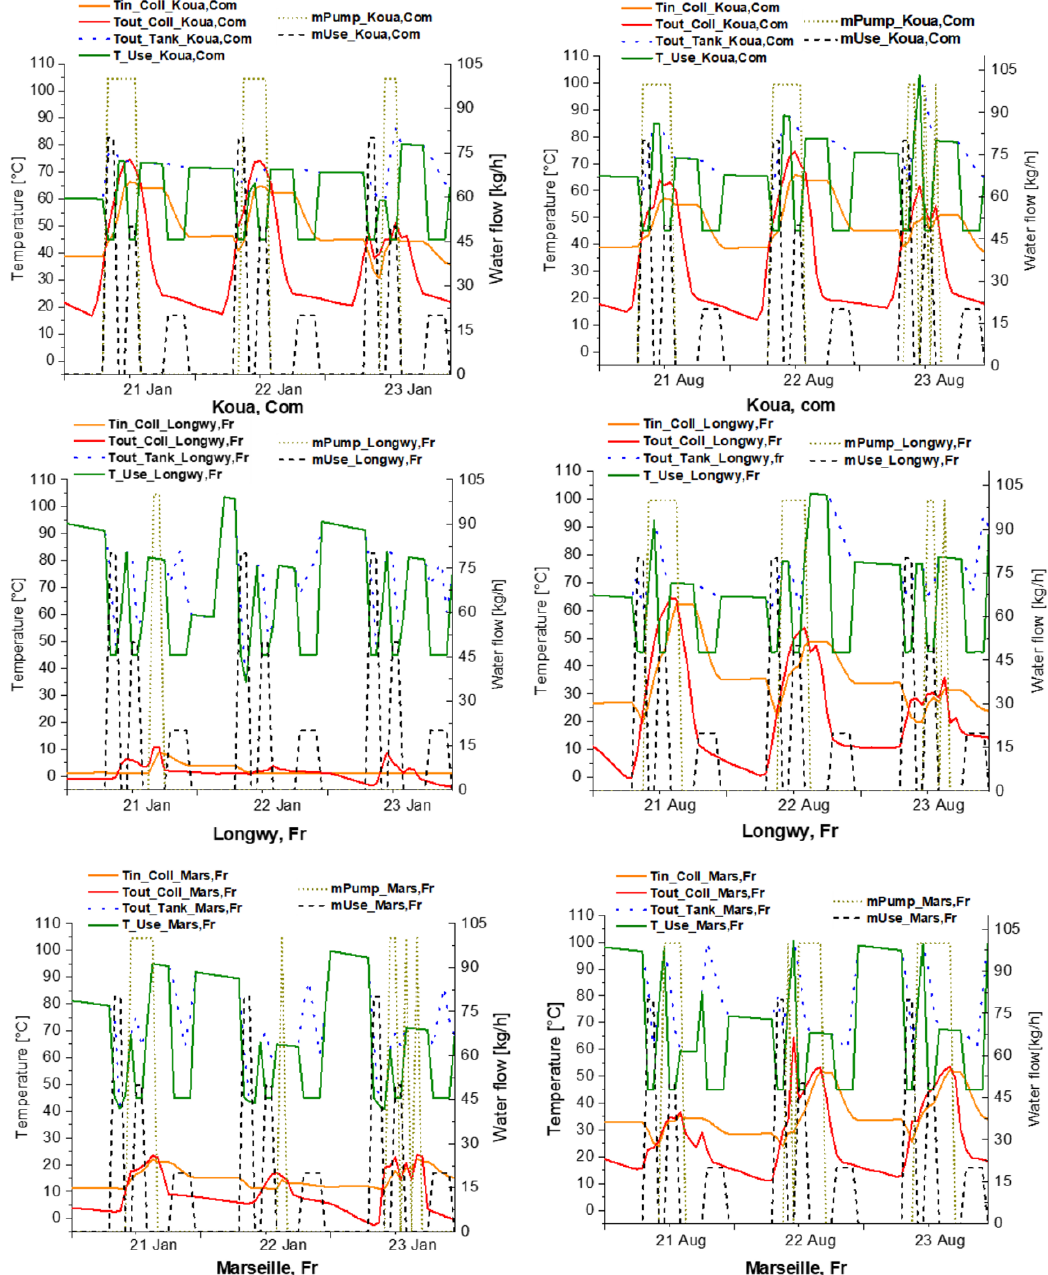
Figure 8. Temperature variations across the PV/T collector and hot water tank and sequences of pump operation and DWH use at Koua, Marseille, and Longwy.